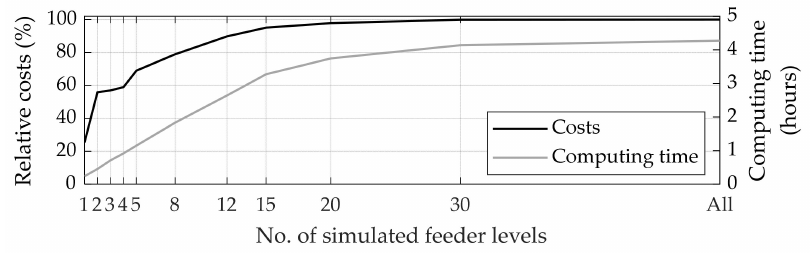
Figure 13. Grid reinforcement costs (relative to the simulation of all feeder levels) and required computing time depending on the number of simulated feeder